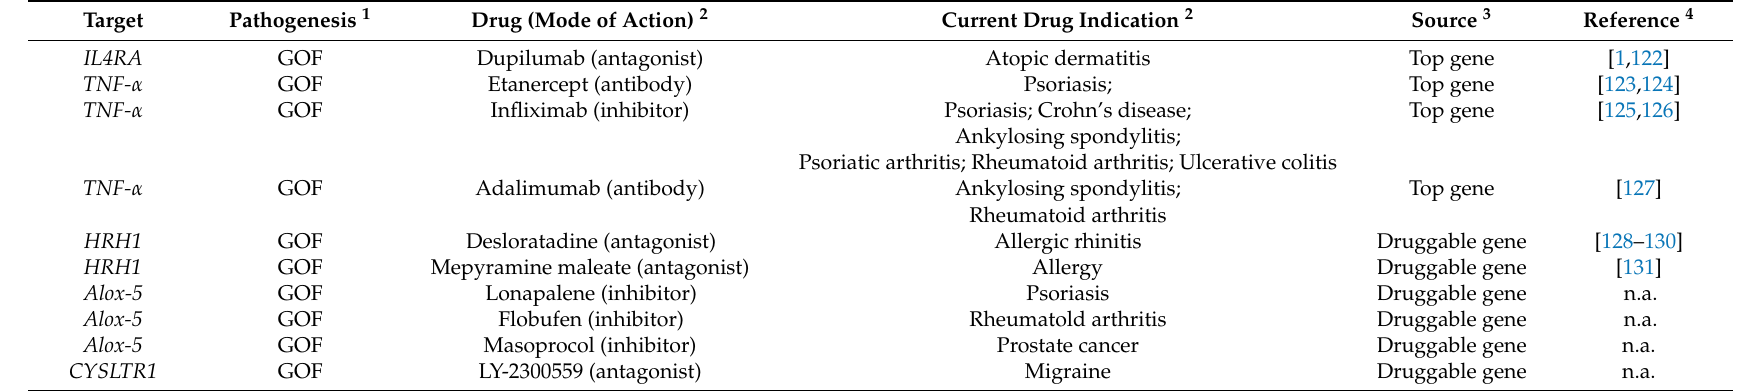
Table 3. Genetics-based drug repositioning for asthma